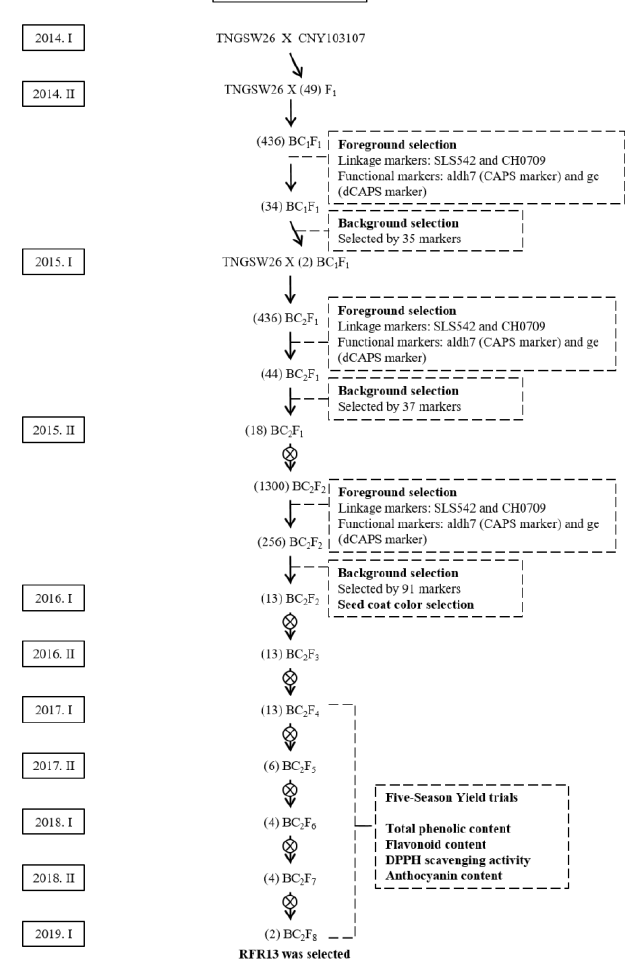
Figure 6. Breeding scheme for red functional rice populations (RFR). Molecular markers were used for both foreground and background selections. Yield trials and antioxidant activity evaluations were performed. The numbers of the selected lines are enclosed in parentheses.